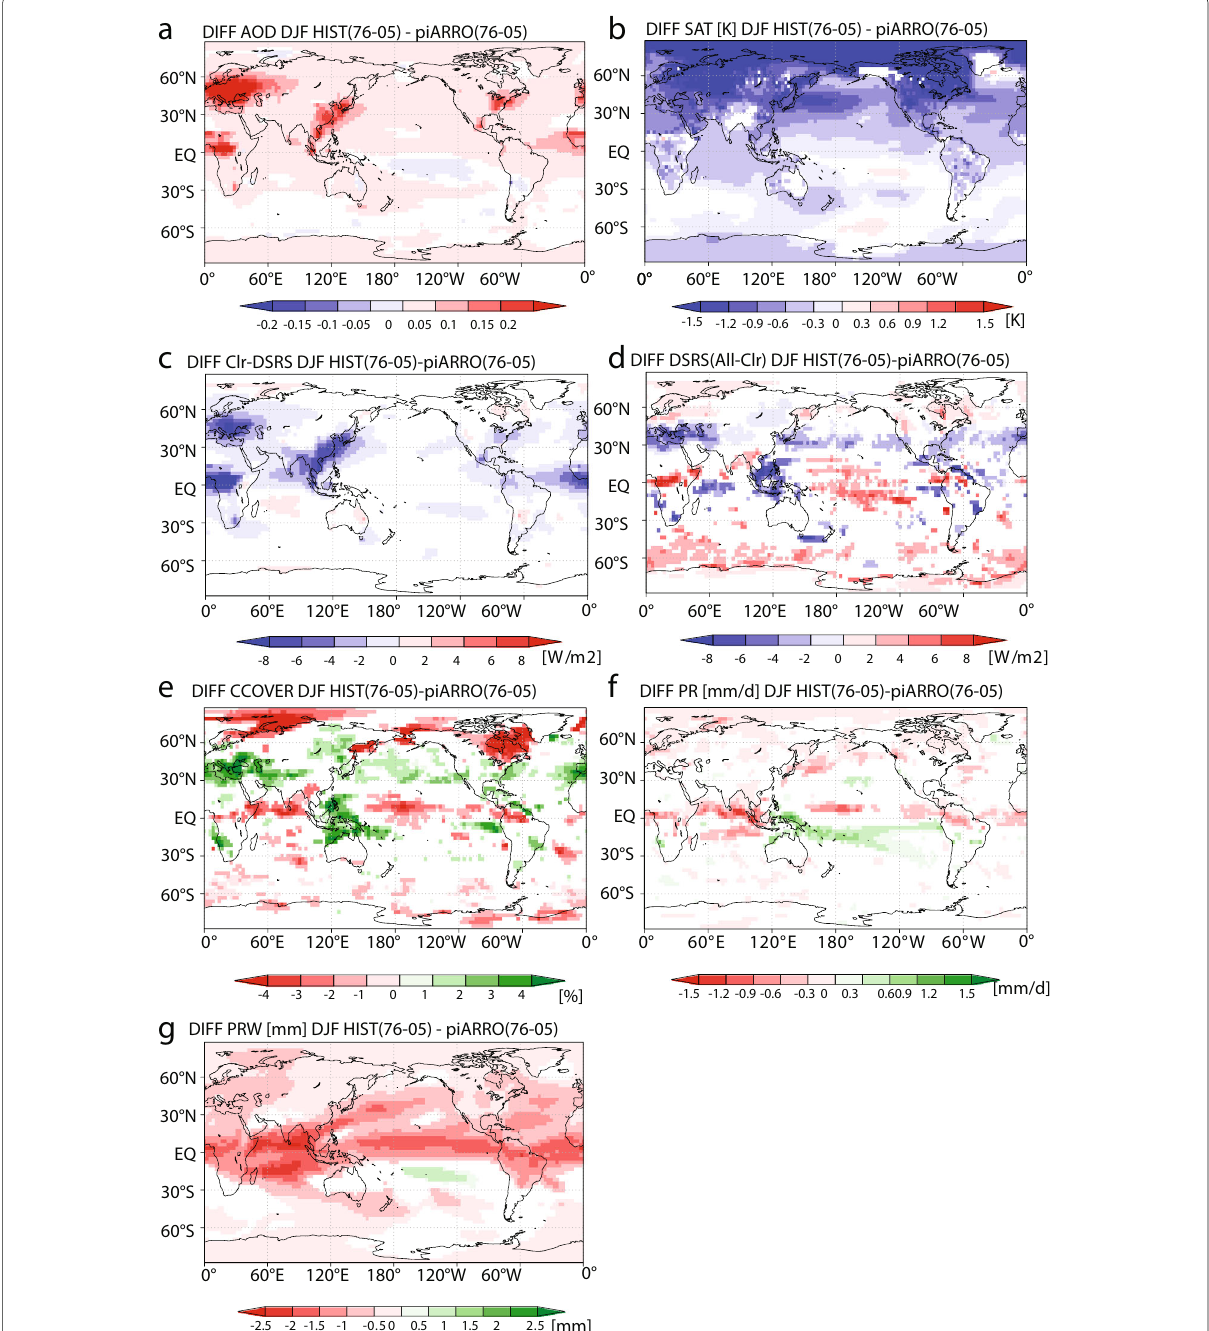
Fig. 7 As in Fig. 3 for both HIST and piAERO, but during DJF averaged over the 30-year period from 1975 to 2004